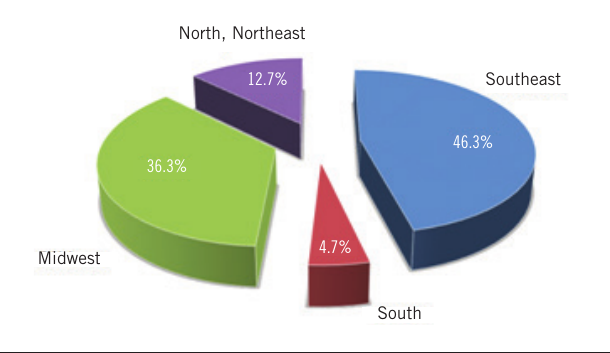
figurE – Distribution of tests performed by geographic region